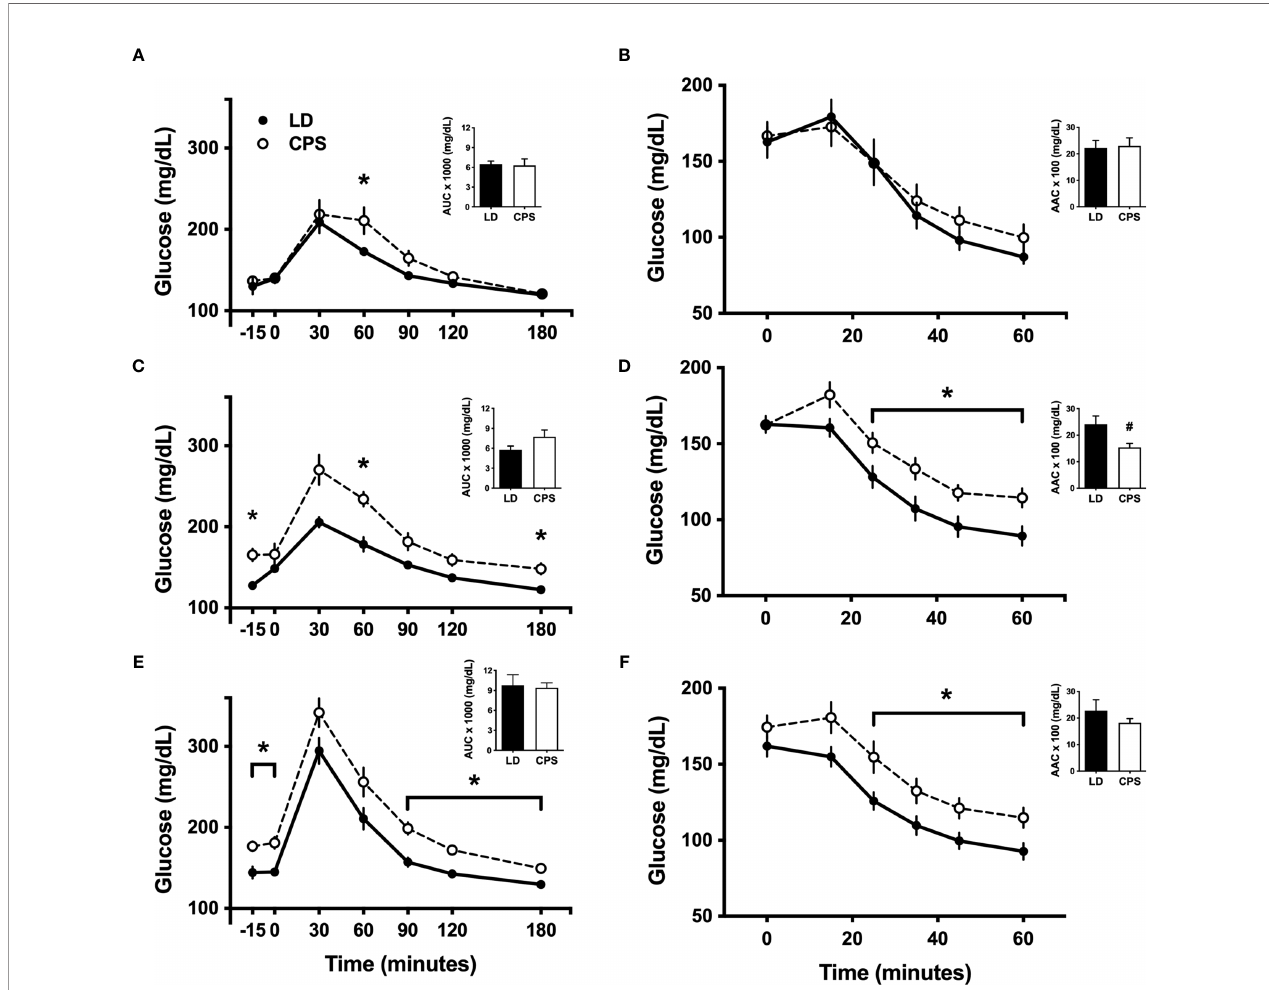
FIGURE 3 | Effects of gestational chronic phase shift of photoperiod on intraperitoneal glucose tolerance test (A, C, E) and intraperitoneal insulin tolerance test (B, D, F) of rats fed with 45% high-fat diet (HFD) for 12 weeks, measured at week 0/basal (A, B) , 6 weeks (C, D) and 12 weeks (E, F) . Data are mean±SEM. Solid line: LD, adult rats that had been gestated under control 12:12 (LD) photoperiod; dashed line: CPS, adult rats that had been gestated under chronic phase shift (CPS) photoperiod. AUC, Area under the curve; AAC, Area above the curve. n = 8 per group. *different from LD ( p < 0.05 pairwise comparison at each time point with Bonferroni correction), # different from LD ( p < 0.05, unpaired t